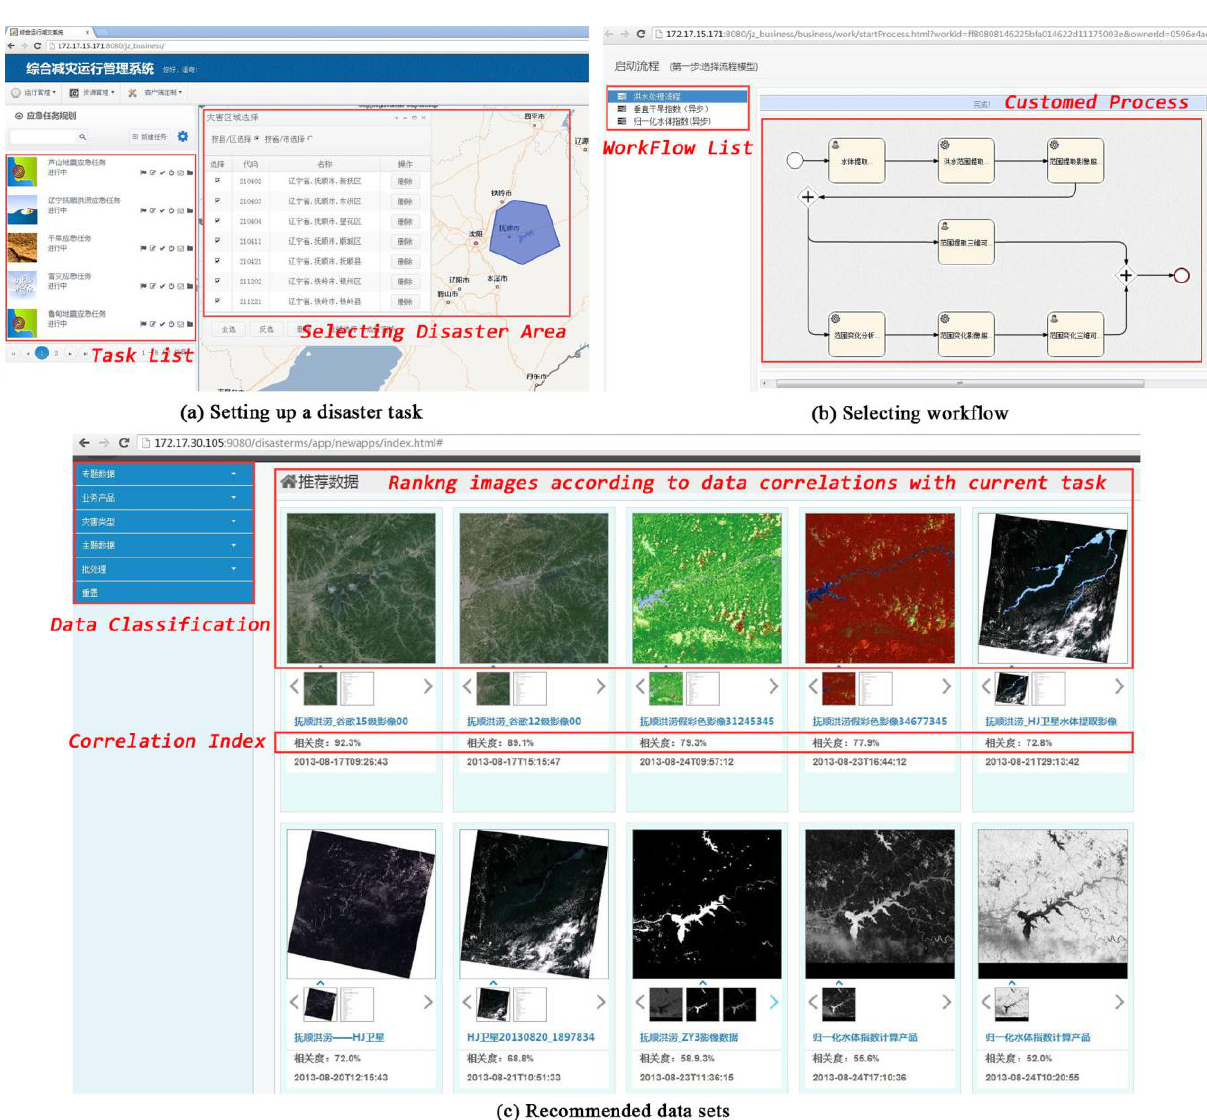
Figure 4. The graphic interface of the prototype